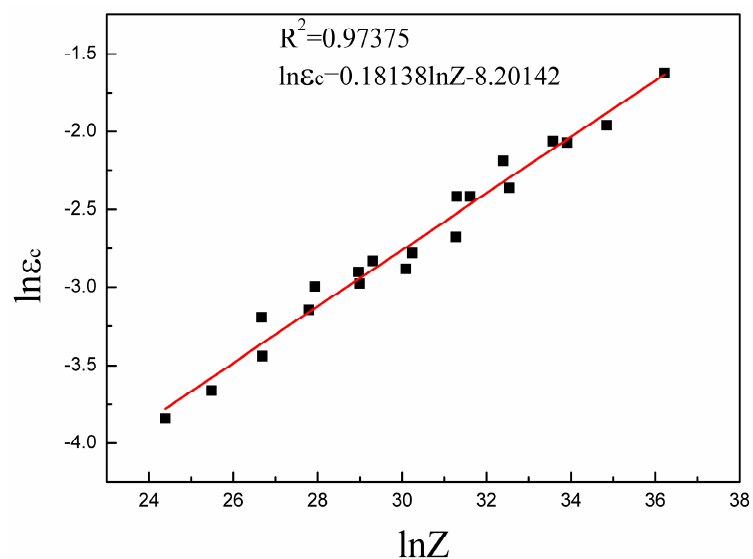
ε Figure 7. The relationship between the Z parameter and ε c . The linear curve is obtained from linear Z . Figure 7. The relationship between the parameter and c . The linear curve is obtained from ε exp ( 383094/ ( 8.31 T )) fitting. Here, the Z parameter is in the form of Z = ( ) Z )31.8383094/(exp TZ ε  = . linear fitting. Here, the parameter is in the form of